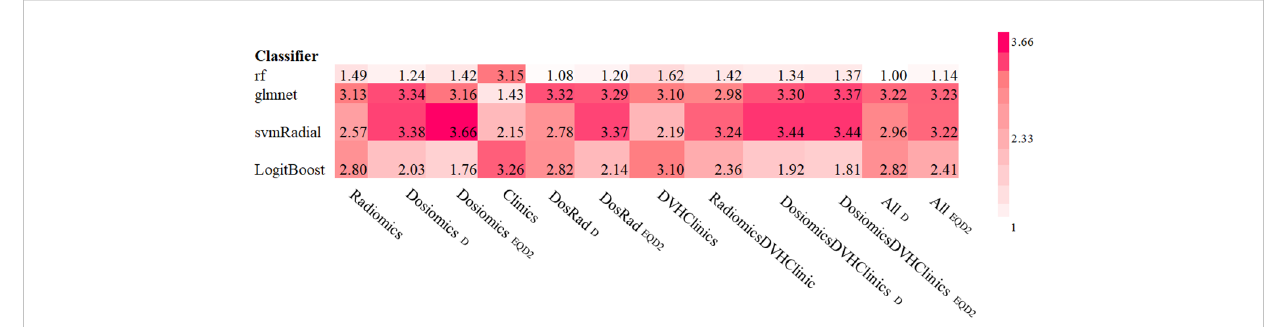
FIGURE 3 Ranked mean AUC values for all classi fi ers and models tested. Subscripted D and EQD2 refer to physical dose and EQD2,